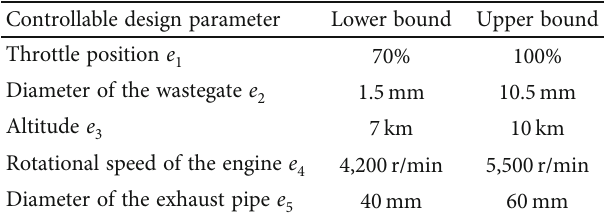
Table 4: Initial simulation conditions for a group of controllable design